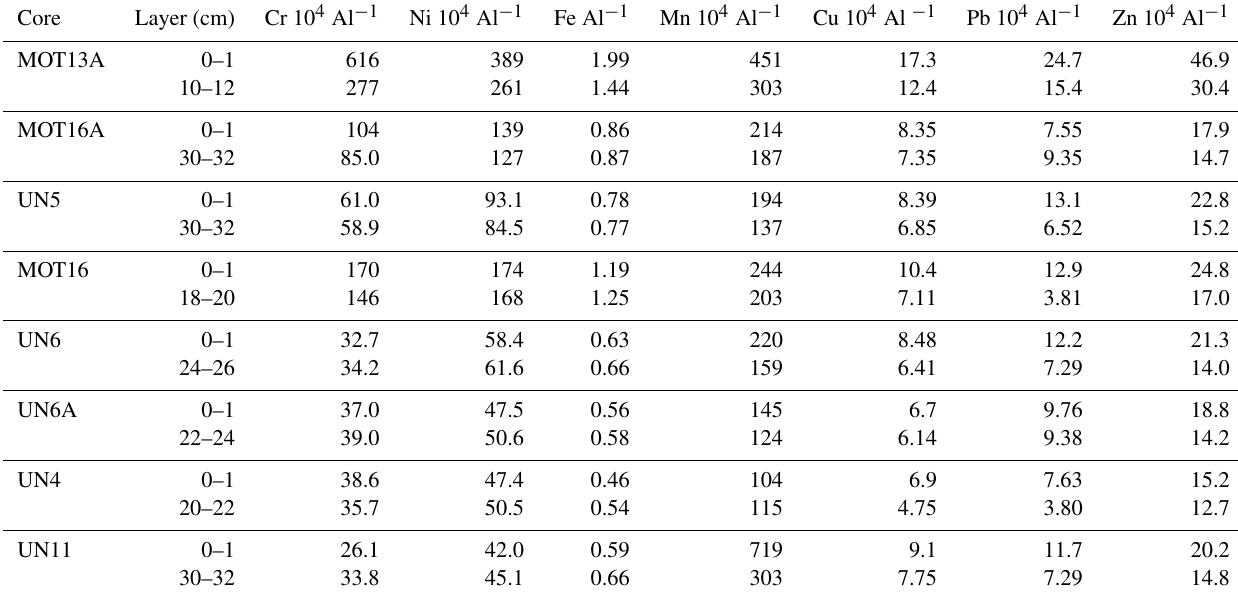
Table A2. The ratios of eight heavy metals to Al in surface and deeper-layer sediments of the collected cores. In cases of the coarse-grained sediment cores MOT13A, MOT16 and UN4, the ratios in the fine-sediment fraction ( f < 63µm) are calculated. Core Layer (cm)